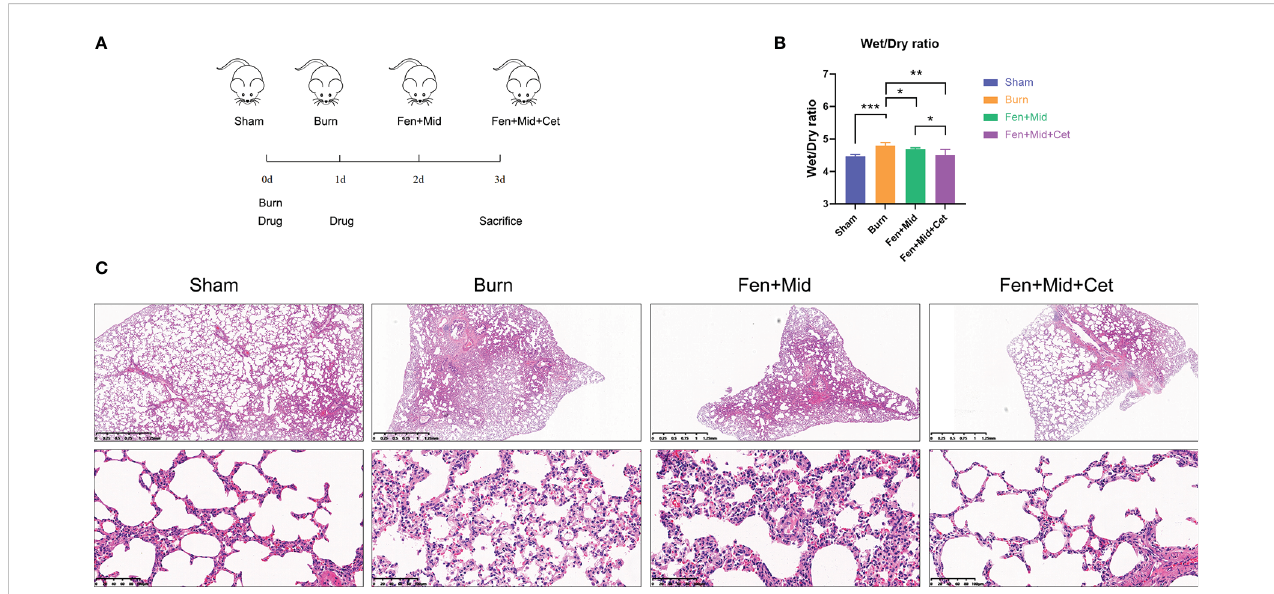
FIGURE 2 Effects of fentanyl and midazolam combined with cetirizine on lung injury in rats after severe burns. (A) Schematic representation of in-vivo study design. Ovall 24 rats were randomly divided into sham scald group (Sham, n=6), large scald group (Burn, n=6), fentanyl + midazolam group (Fen+Mid, n=6), and fentanyl + midazolam + cetirizine group (Fen+Mid+Cet, n=6). The large scald rat model was constructed on day 0. The drugs were administered on day 0 and day 1. The plasma, liver, and lung tissues of rats were collected on day 3. (B) The wet/dry ratio of lung tissue of rats in different groups was measured. n = 6. (C) The lung tissues of rats in each group were stained with HE. The scale bar indicates 1.25mm or 100 µm, respectively. * p < 0.05, ** p < 0.01, *** p <